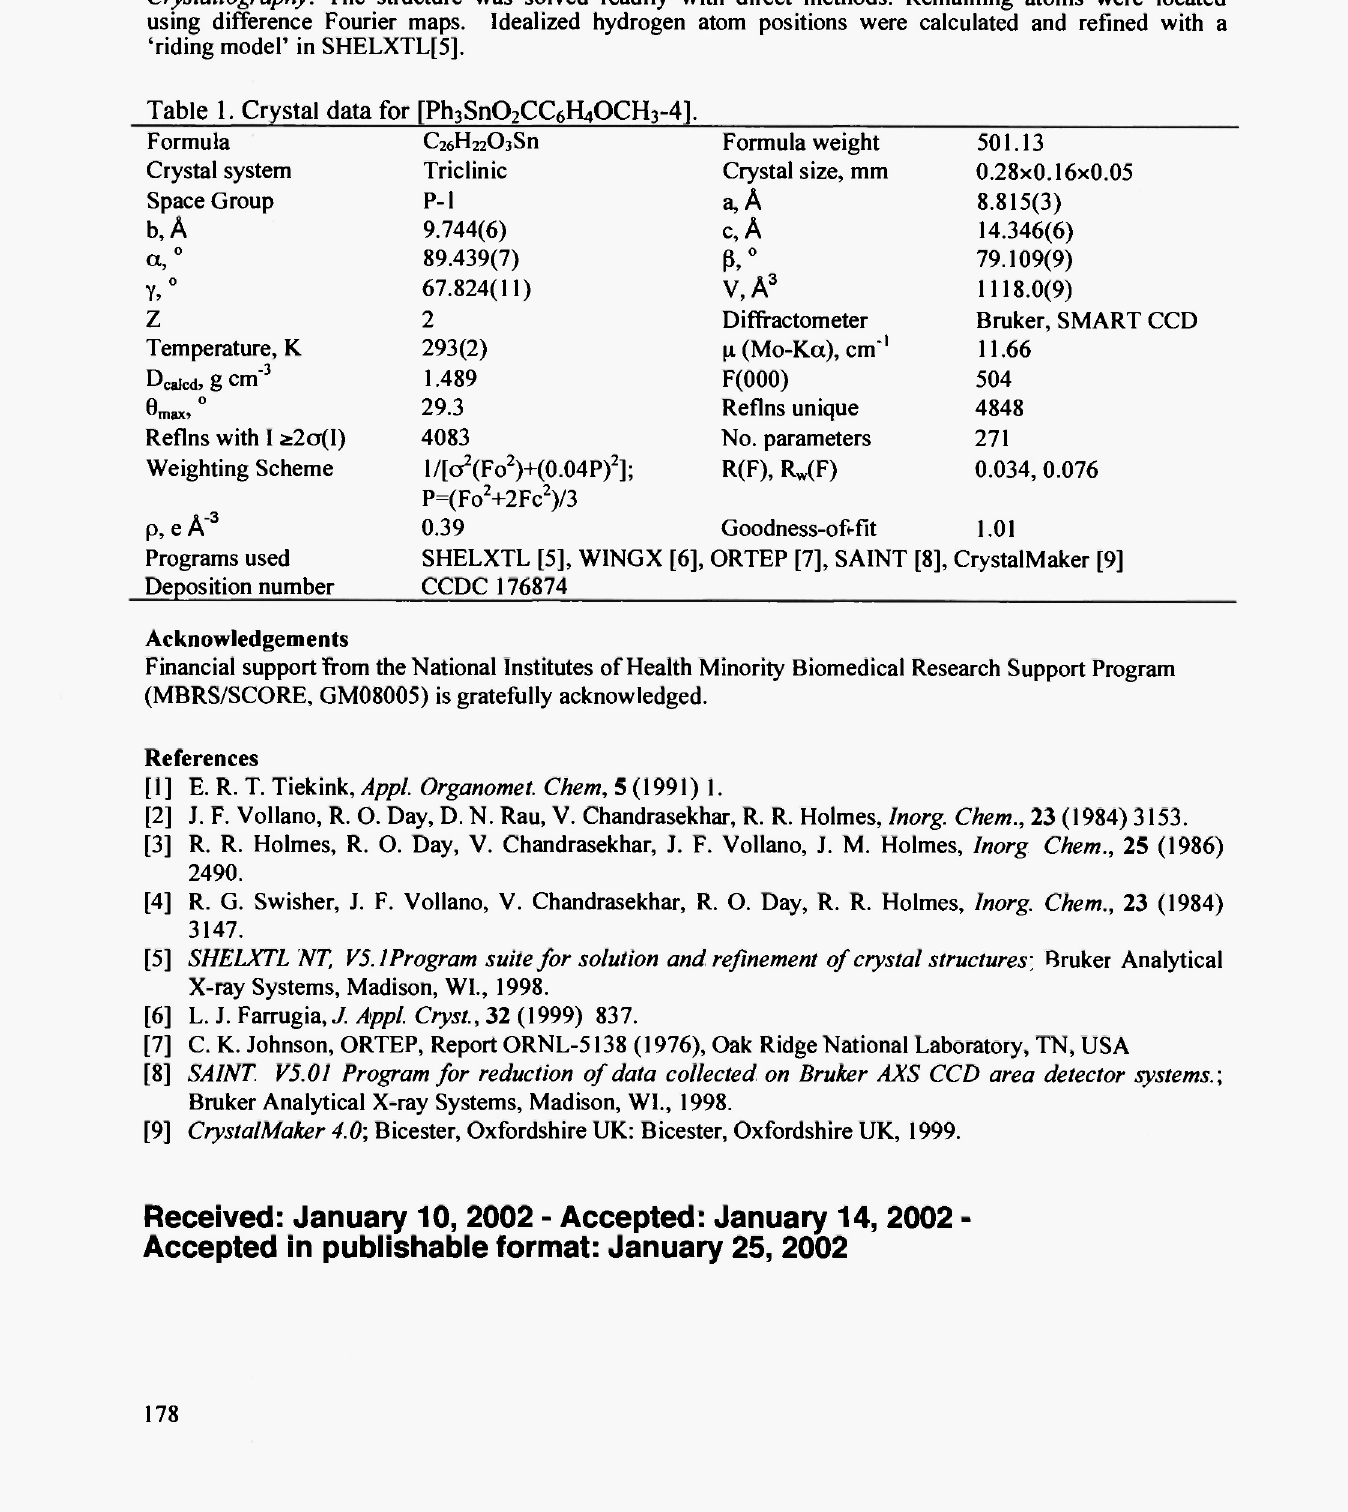
Table 1. Crystal data for [ P h j S n O z C C e ^ O C H j ^